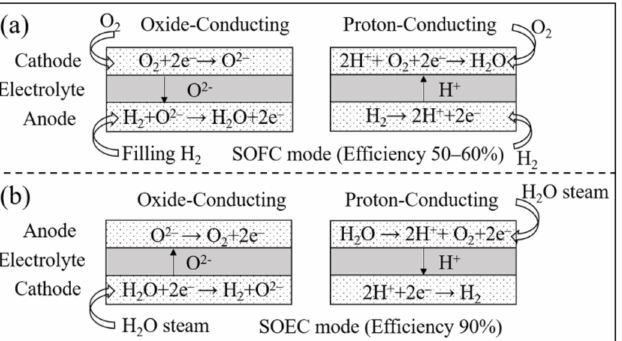
Figure 1. Schematic diagram of the structure and operating principle of SOFCs and SOECs. ( a ) SOFC mode with an oxide-conducting and proton-conducting electrolyte, respectively; ( b ) SOEC mode. An energy conversion efficiency of 50–60% can be achieved in SOFC mode [1] and 90% in SOEC mode